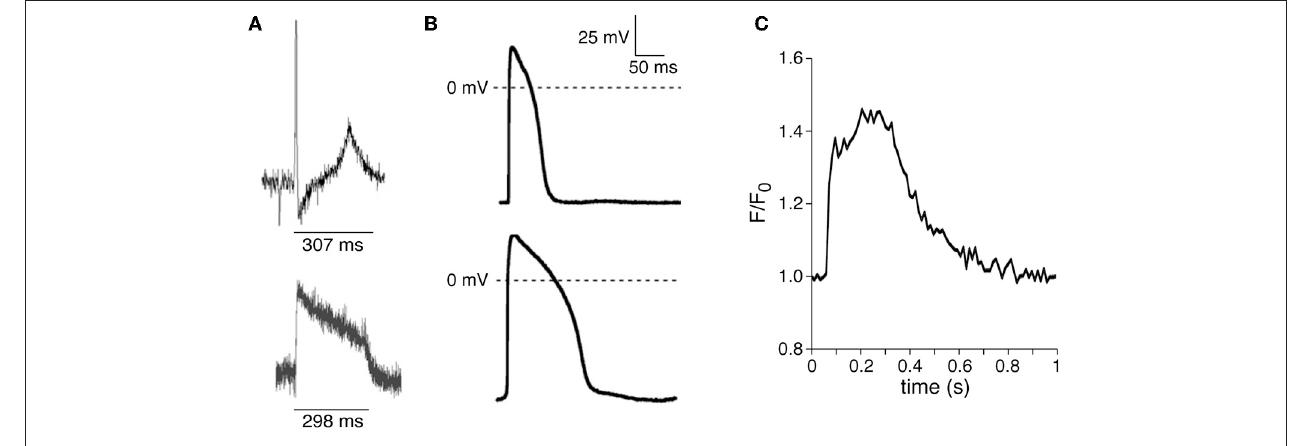
FIGURE 1 | (A) Typical ECG recording ( top ) and optically mapped action potential ( bottom ) in adult zebrafish heart. Adapted from Tsai et al. (2011), with the permission of Elsevier. (B) Typical atrial ( top ) and ventricular ( bottom ) action potentials recorded from spontaneously beating intact zebrafish hearts.